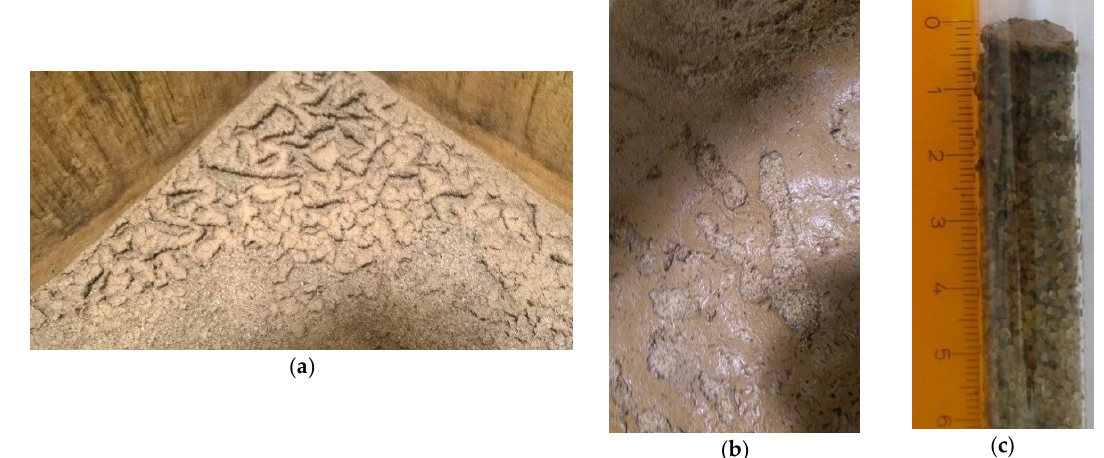
Figure 5. Clogged layer at the porous media–water boundary. ( a ) Dried state; ( b ) wet state; ( c ) approximate thickness of 2–3 mm.